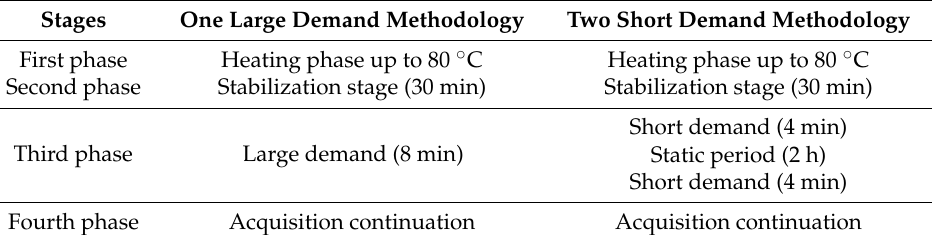
Table 2. Stages of the test methodologies.